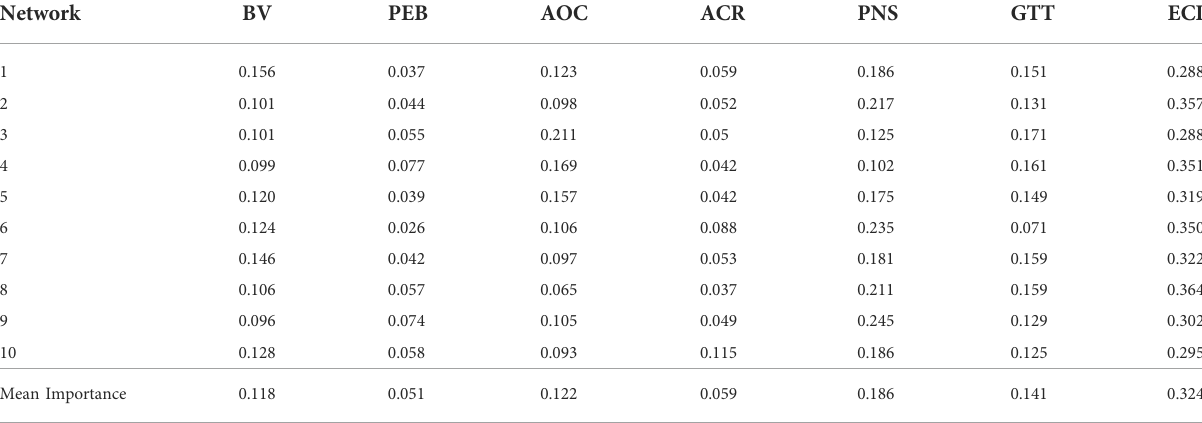
TABLE 9 Sensitivity